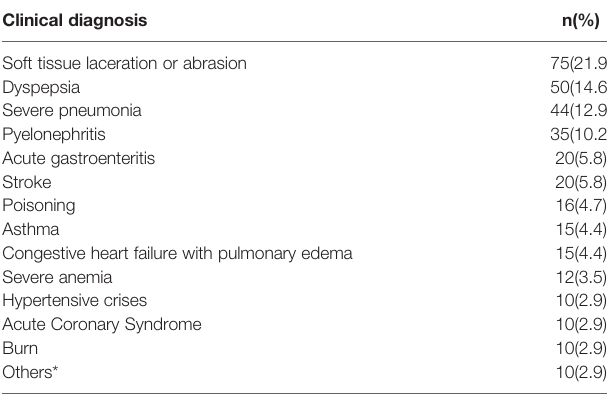
TABLE 2 | Speci fi c clinical diagnosis of patients admitted to the emergency department of HFSUH, Harar, Ethiopia, 2018(n = 342).